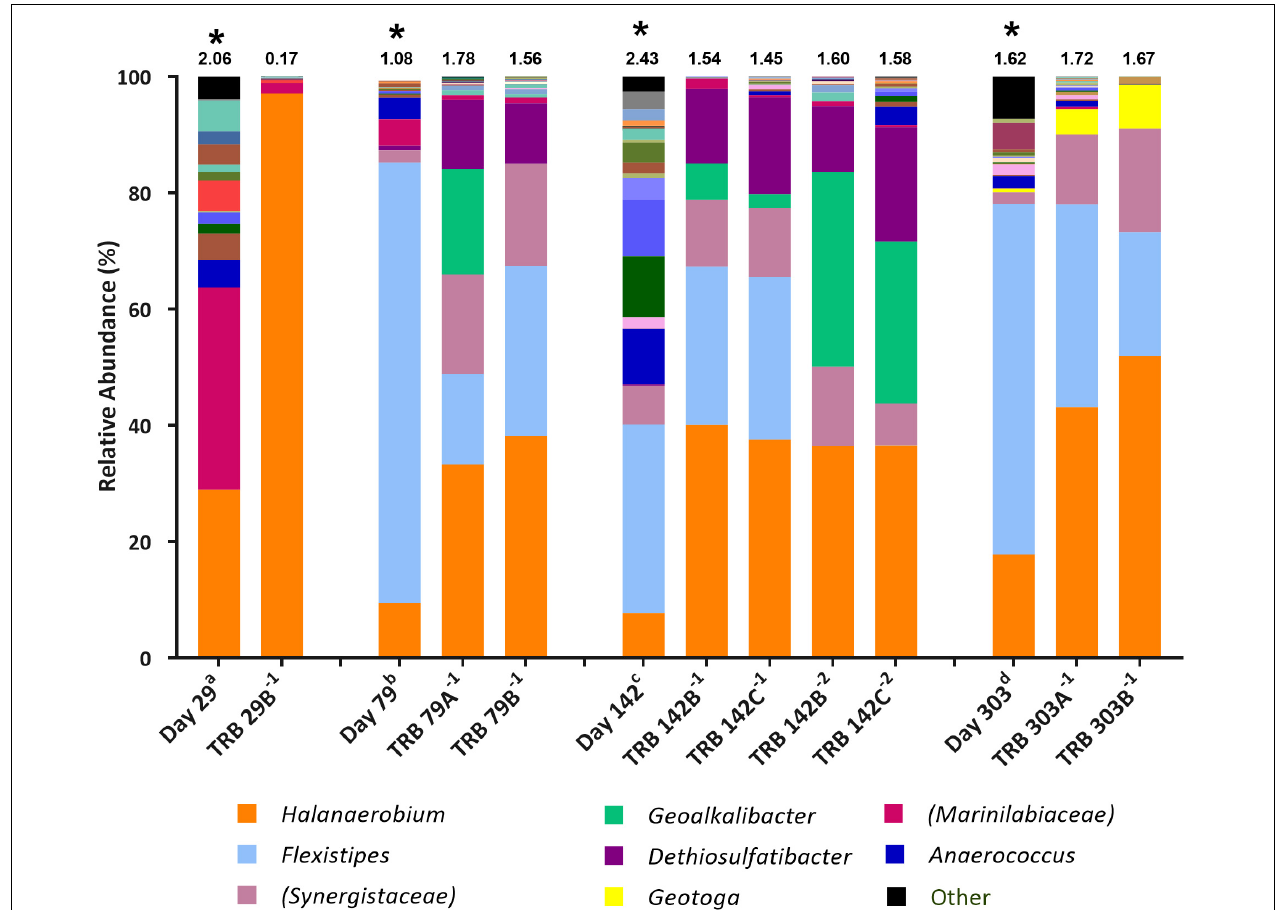
FIGURE 3 | Genus-level microbial community composition of MPN enrichments for TRB based on 16S rRNA gene sequencing. Enrichments were conducted at 10% salinity. Genera that constitute less than 0.1% combined abundance were grouped as “other.” Where genus level could not be resolved the highest resolved taxonomic level is given in brackets. The Shannon diversity index calculated from operational taxonomic units is displayed above each bar. a 808 days storage, b 758 days storage, c 695 days in storage, and d 534 days storage, * indicates inocula. Key taxa are highlighted in legend. Enrichments were conducted in triplicate where A, B, C refers to specific replica and superscript power refers to dilution factor of the positive end-points